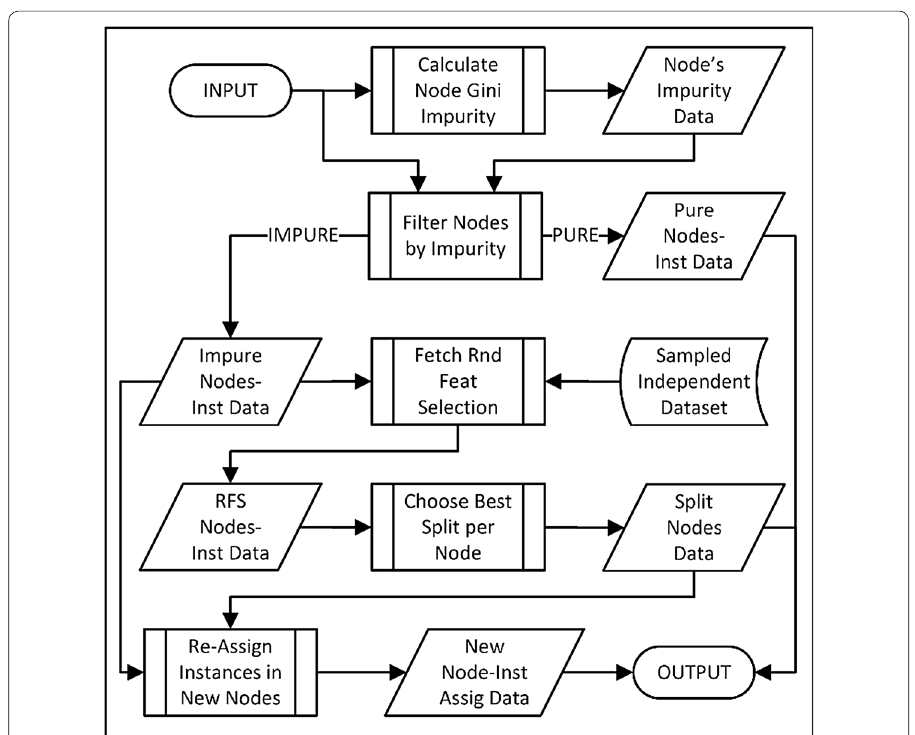
Fig. 8 Optimized Random Forest split/partition loopbody